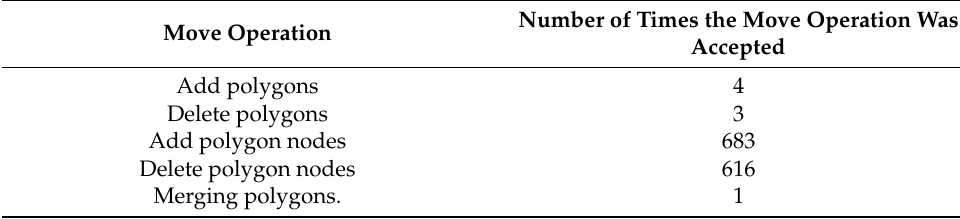
Table 1. Number of times the move operation was accepted. Number of Times the Move Operation Was Move Operation Accepted Add polygons 4 Delete polygons 3 Add polygon nodes 683 Delete polygon nodes 616 Merging polygons.